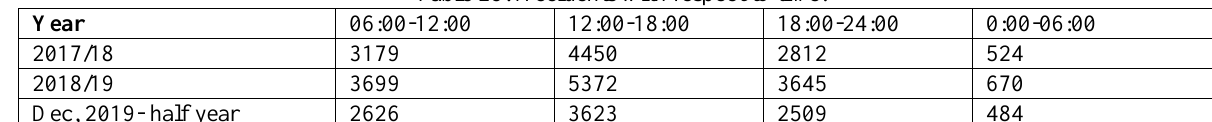
Table 25: Accidents with respect to time.